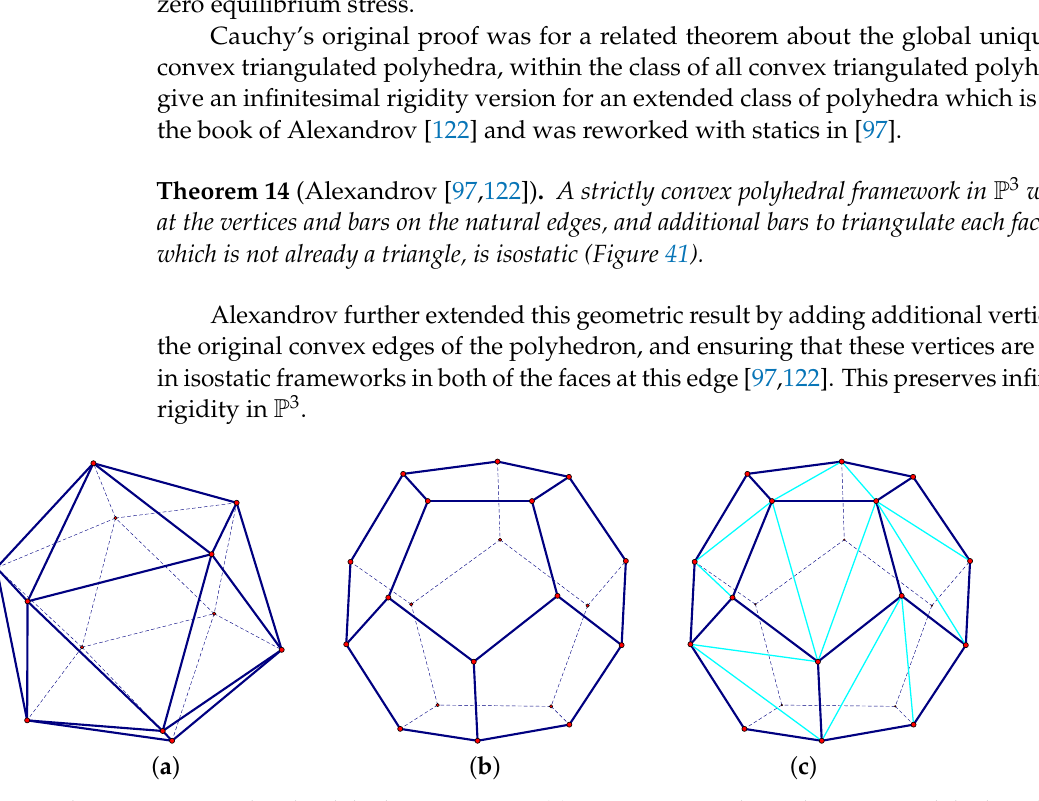
Figure 41. A strictly convex triangulated polyhedron is isostatic ( a ). A more general strictly convex polyhedron ( b ) is isostatic if all faces are triangulated ( c